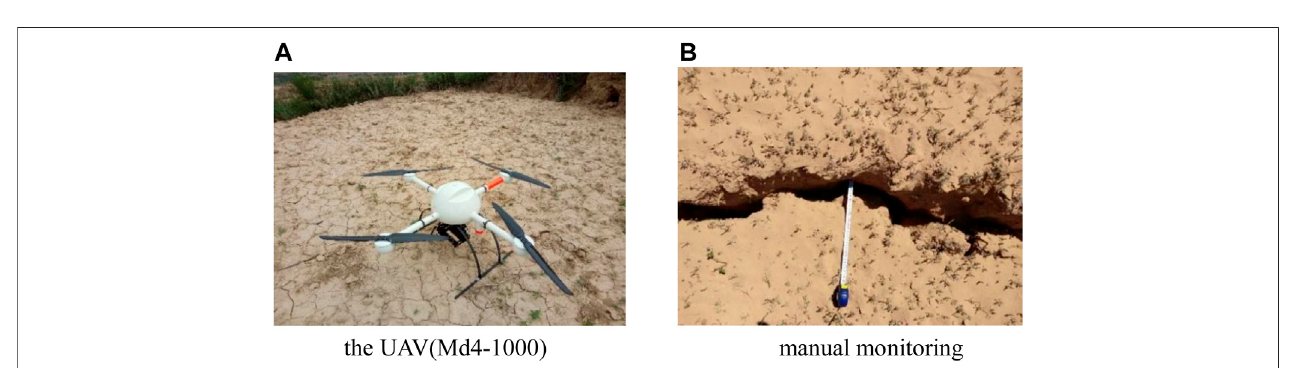
FIGURE 3 | Methods for investigation of surface damage. (A) The UAV(Md4-1,000). (B) Manual monitoring.